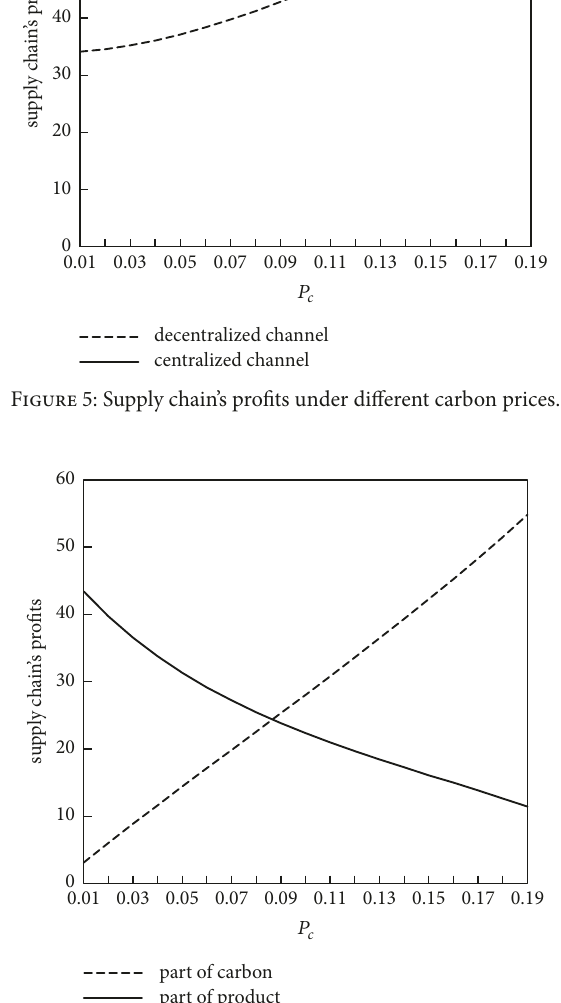
Figure 4: Carbon emissions under different carbon prices.